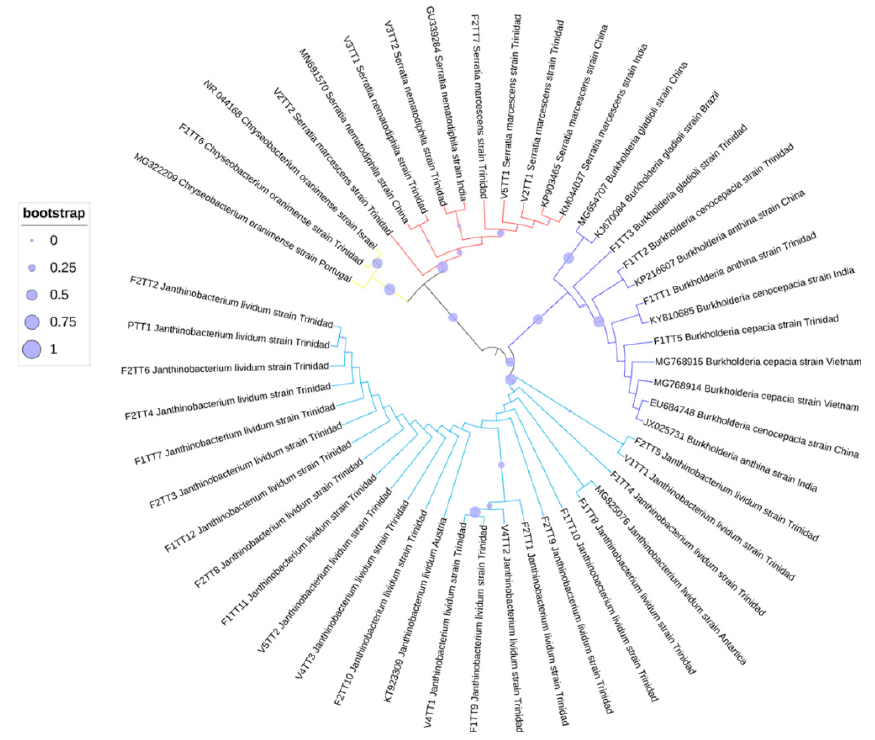
Figure 5. Unrooted ML phylogenetic tree for co-isolated bacteria based on 16S sequence compari- sons.